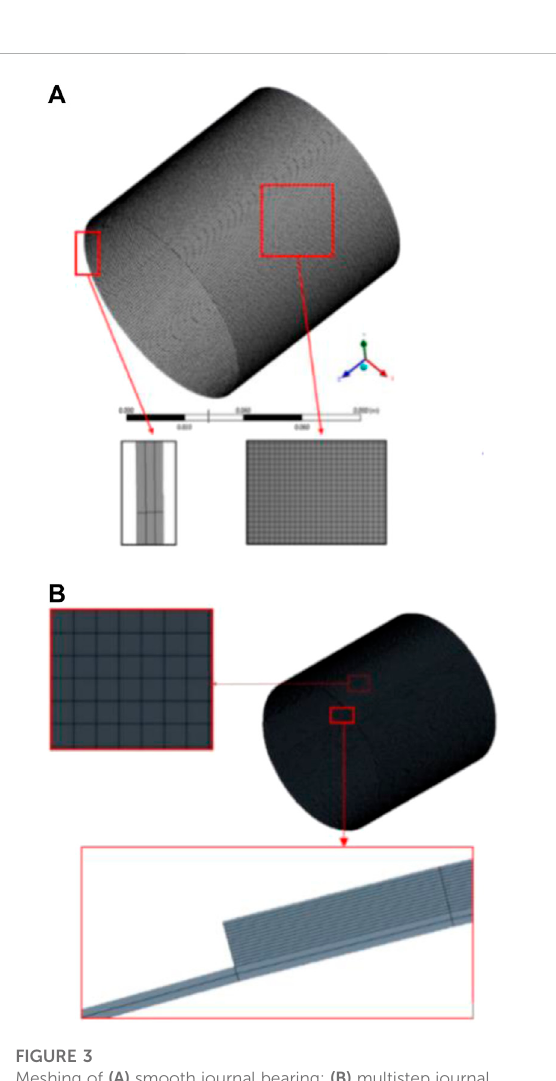
FIGURE 3 Meshing of (A) smooth journal bearing; (B) multistep journal